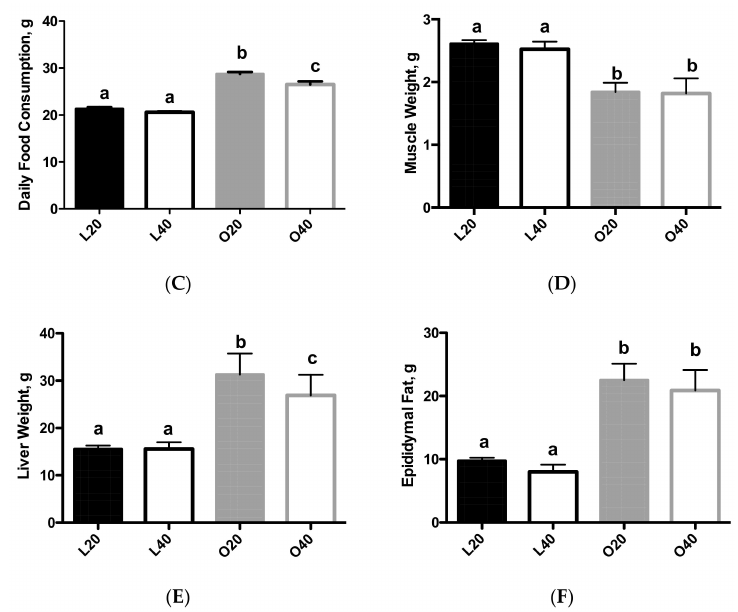
Figure 1. Body weight, food intake and body composition following 12 weeks of consuming either a 20% protein or 40% protein diet in lean control (L) or obese Zucker (O) rats. ( A ) Body weight gain over time; ( B ) Total weight gain over the 12-week diet intervention; ( C ) Average daily food consumption; ( D ) Muscle weight is a combination of gastrocnemius, soleus and plantaris muscles from the right hindlimb; ( E ) Liver weight; ( F ) Epididymal fat pad weight. Values are means + SEM. Data was analyzed using one-way ANOVA. Values without a common letter differ, p < 0.05. L20, lean 20% protein; L40, lean 40% protein; O20, obese 20% protein; O40, obese 40%